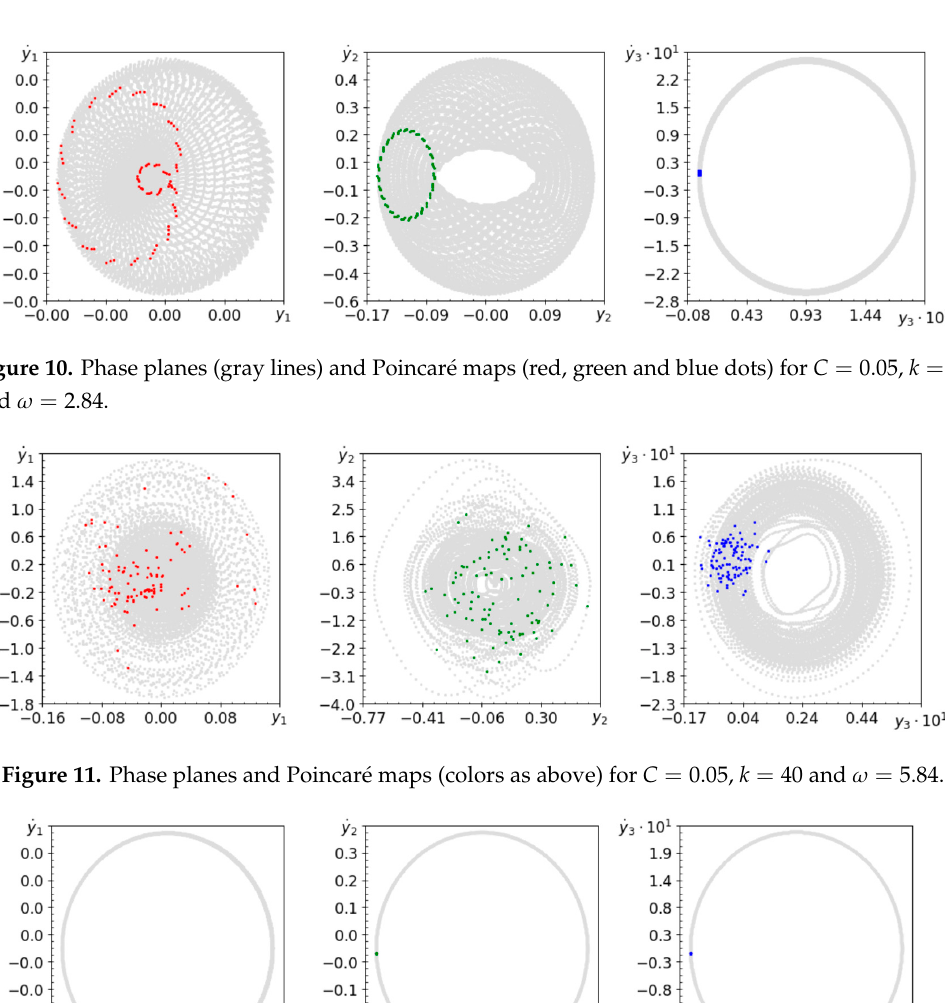
Figure 9. Phase planes (gray lines) and Poincaré maps (red and green dots) for (cid:1827) = 0.15 , (cid:2033) = 5.04 .